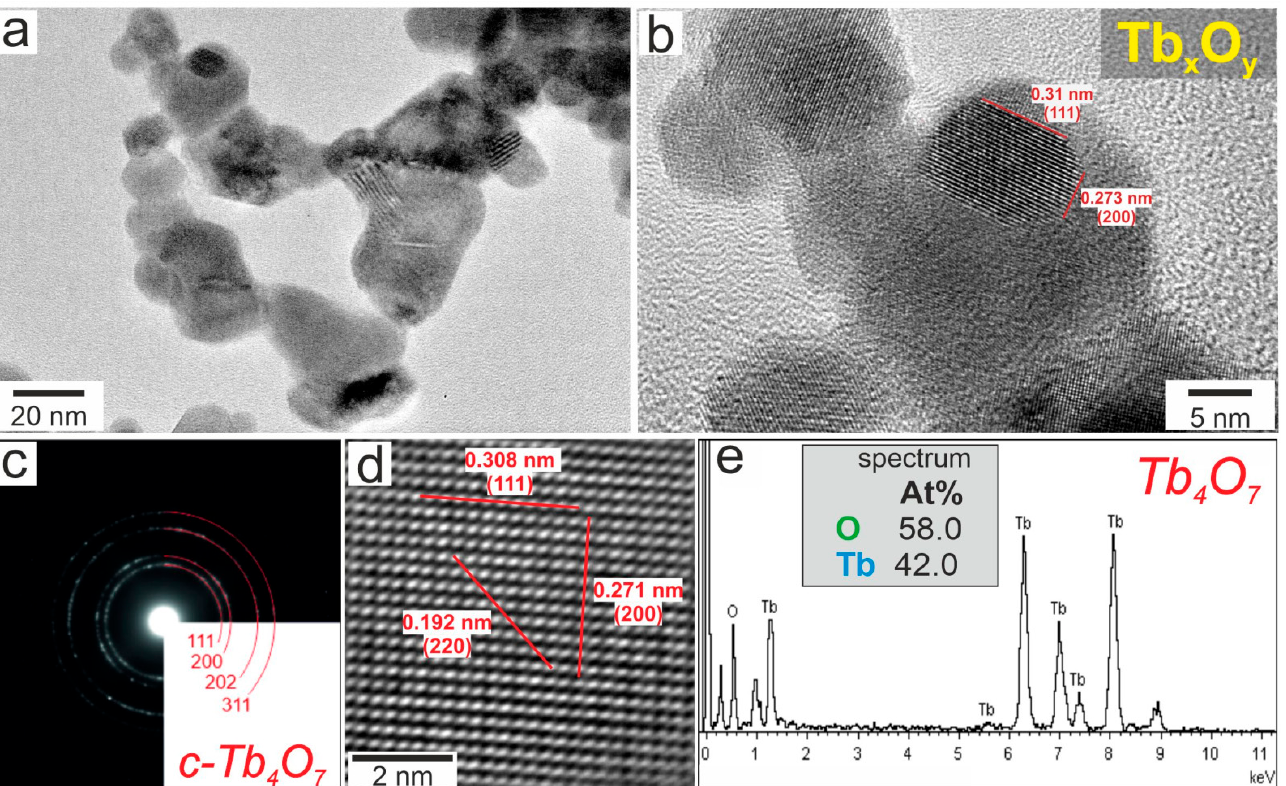
Figure 7. ( a , b ) HR TEM images of terbium oxide (Tb x O y ) powder, ( c ) diffractogram of cubic c-Tb 4 O 7 structure, ( d ) average background subtraction filtering (ABSF) image, and ( e ) EDS spectrum of Tb 4 O 7 oxide.